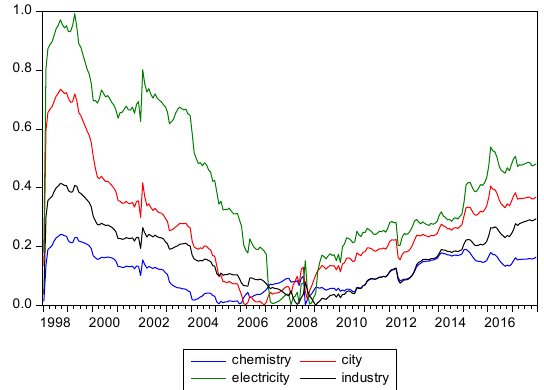
Figure 3. Time-varying elasticity of the four types of gas usage.